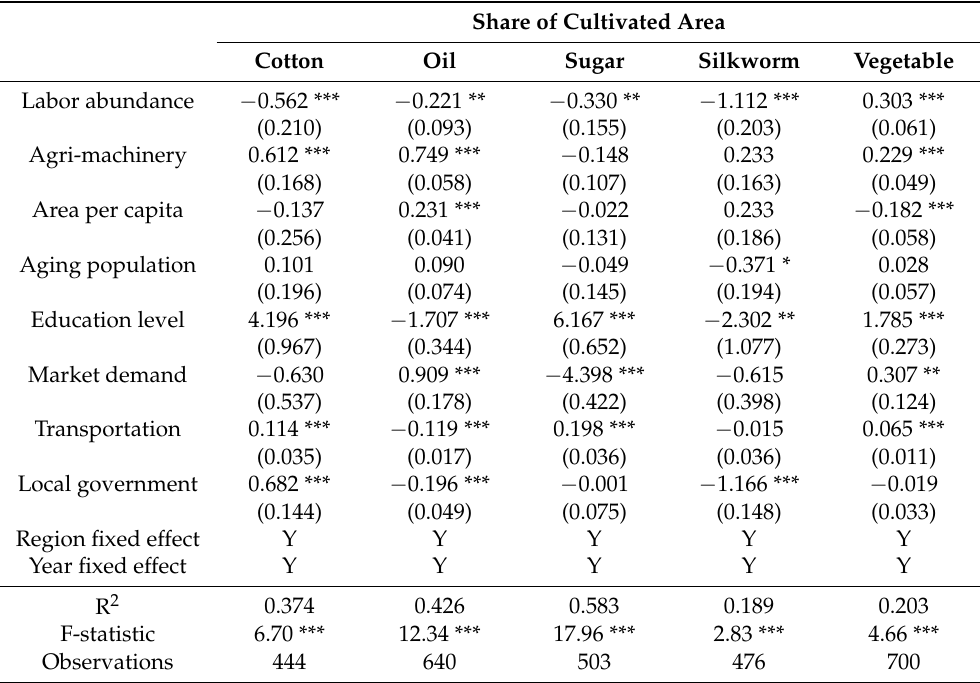
Table 5. The estimated results of regional differences in labor endowment on agricultural production location adjustment using labor